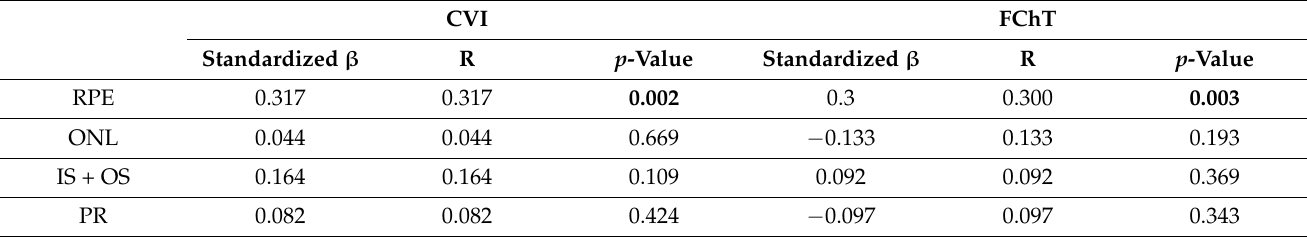
Table 9. Univariate linear regression between retinal layer thickness and choroidal